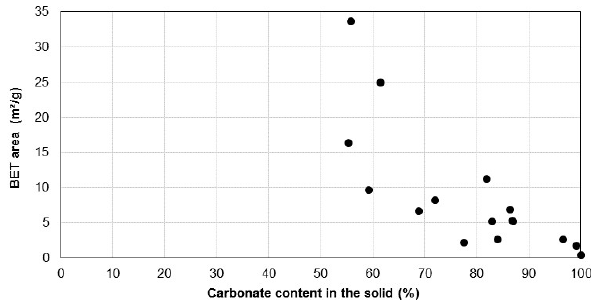
Figure 3: BET area vs. and carbonate content in the fine particles for various operating